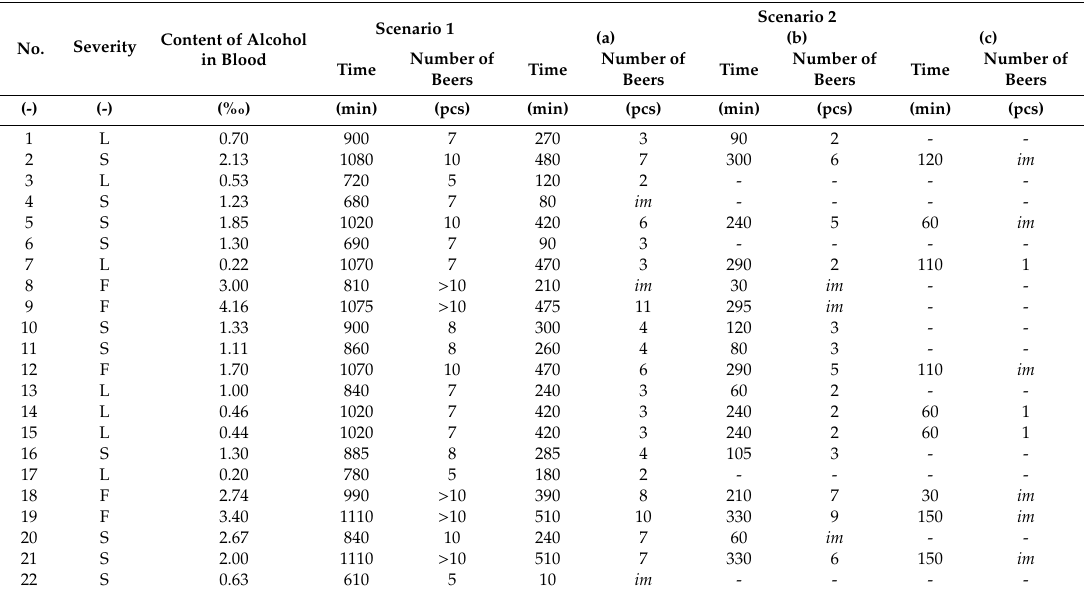
Table 2. Estimated numbers of consumed alcoholic beverages (“large beers”) (own elaboration).